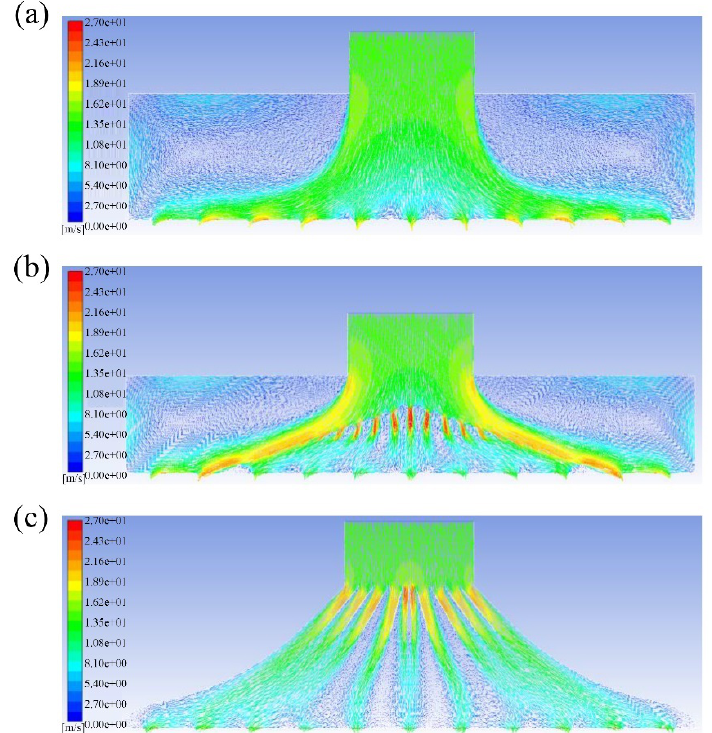
Figure 15. Velocity distribution in the inlet header under different configurations: ( a ) Direct transition duct; ( b ) triangle transition duct; ( c ) quasi-parabola transition duct.